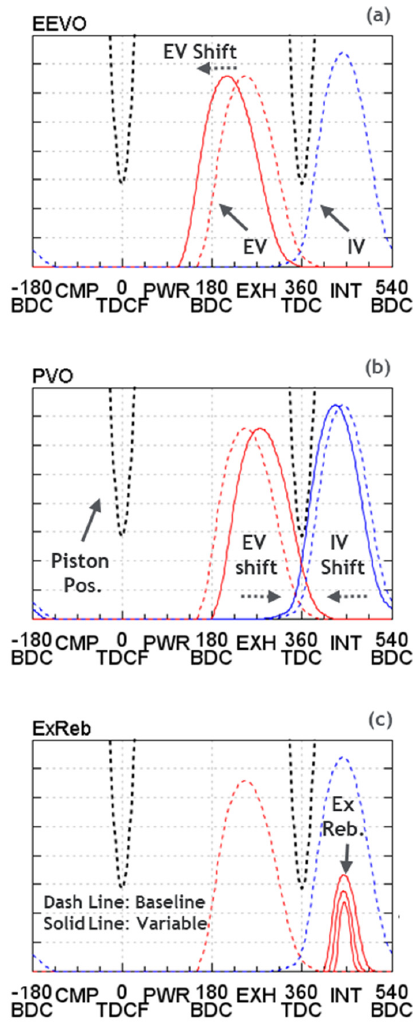
Figure 7. Simulated valve lift profiles for the ( a ) EEVO, ( b ) PVO, and ( c ) ExReb strategies.